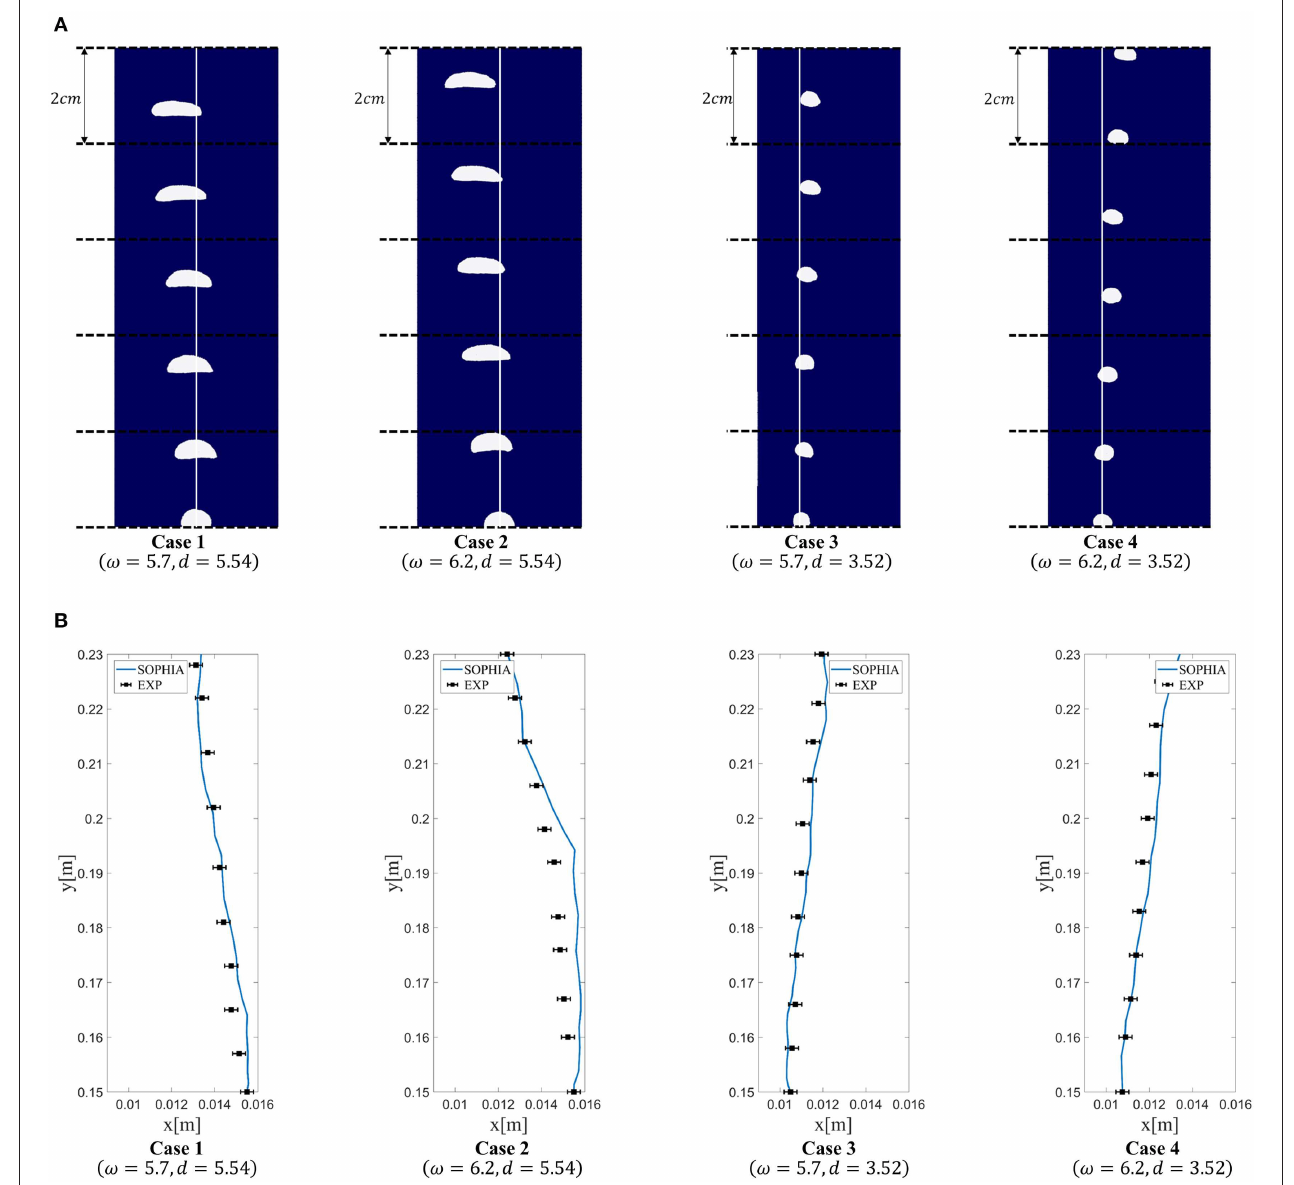
FIGURE 11 | The simulation results for bubble lift force: (A) bubble floating sequence with rendering and (B) comparison of bubble trajectories with the experimental data (Tomiyama et al., 2002).